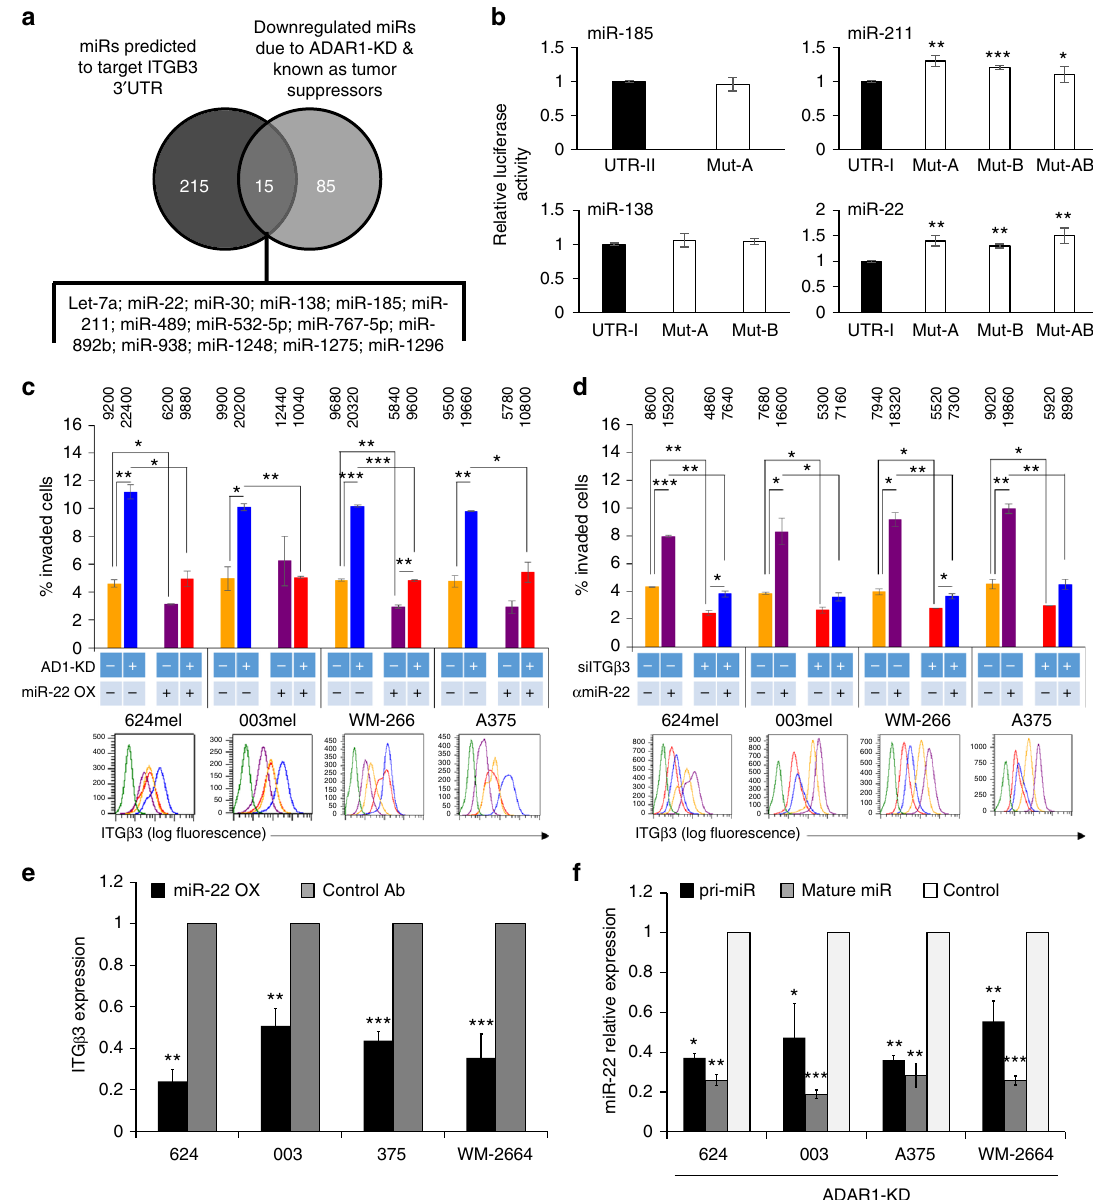
Fig. 3 ITGB3 expression is directly controlled by miR-22. a Venn diagram showing the number of differentially regulated miRNA, which are both known as tumor suppressor, demonstrate reduced expression due to silencing of ADAR1 and predicted to target ITGB3. The 15 identi fi ed miRNAs are indicated below the diagram; b dual luciferase assays. UTRs (UTR-I or UTR-II) and MUT-UTRs (UTR-MUT-A, UTR-MUT-B, and UTR-MUT-AB) denote ITGB3 3 ′ -UTR segments containing the reference sequence or mutated sequence in the binding site of the respective miR; c effect of miR-22 overexpression (miR-22 OX + ) or negative control (miR-22 OX − ) on the invasion rate and ITGB3 expression in four melanoma lines with ( + ) or without ( − ) ADAR1 silencing (AD1- KD). The color code for each treatment scenario is identical for invasion and ITGB3 FACS data; d effect of anti-miR-22 ( α miR-22 + ) or negative control ( α miR-22 − ) on the invasion rate and ITGB3 expression in four melanoma lines with ( + ) or without ( − ) ITGB3 silencing (siITG β 3). The color code for each treatment scenario is identical for invasion and ITGB3 FACS data. Numbers above the bars represent the absolute cell count of invading cells; e effect of overexpression of miR-22 or control on mRNA of ITGB3 in four indicated melanoma lines. f Expression of both pri- and mature miR-22 form in four ADAR1- KD cell lines, as indicated in the fi gure, was examined by qRT-PCR. Results represent the mean ± SE of three biologically independent experiments, each performed in triplicates. Asterisks represent P values: * P < 0.05; ** P < 0.01; *** P < 0.001 (two-tailed t